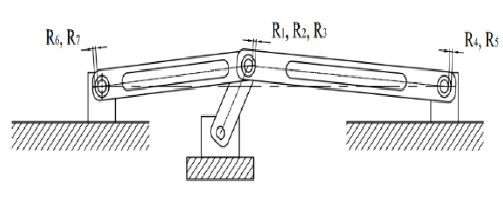
Fig. 2: Planar Slider-crank mechanism with revolute clearance joints. Tab. 1: Simulations characteristics.